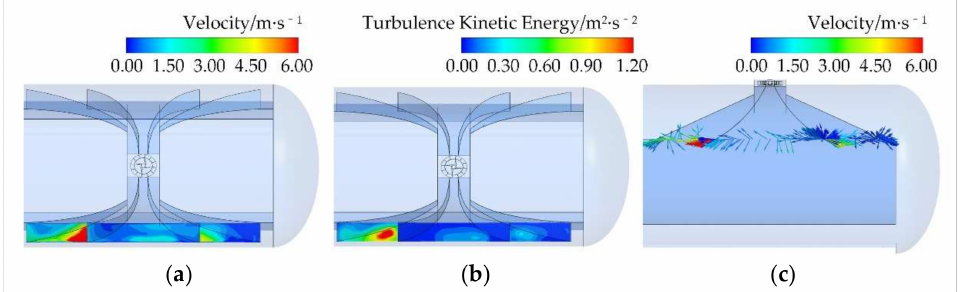
Figure 2. The flow-field characteristics at the outlet of the guide channel. ( a ) Velocity contour; ( b ) turbulent kinetic energy contour; ( c ) velocity